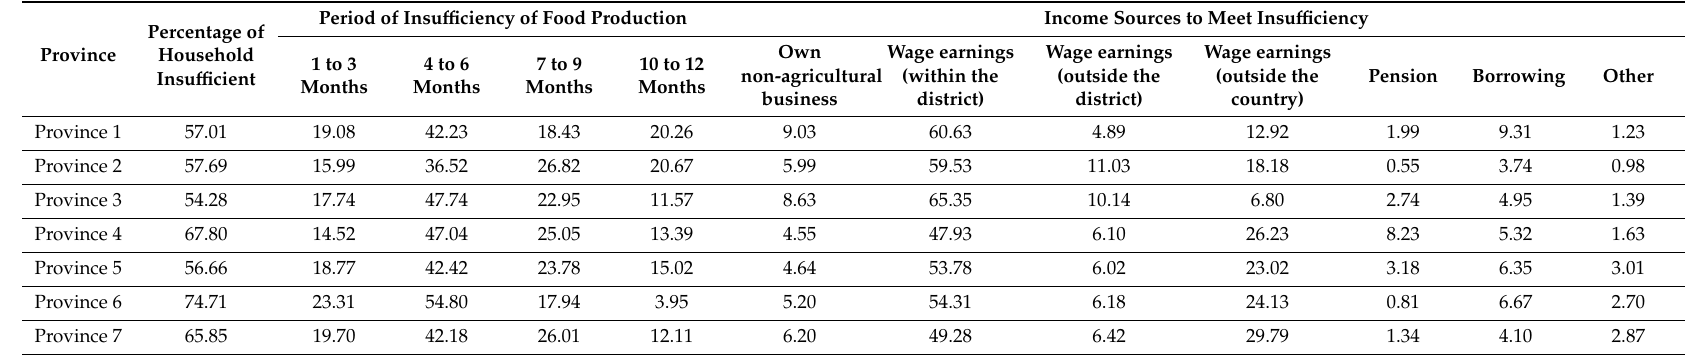
Table 5. Period of insu ffi ciency in both agricultural production and incomes by the percentages of